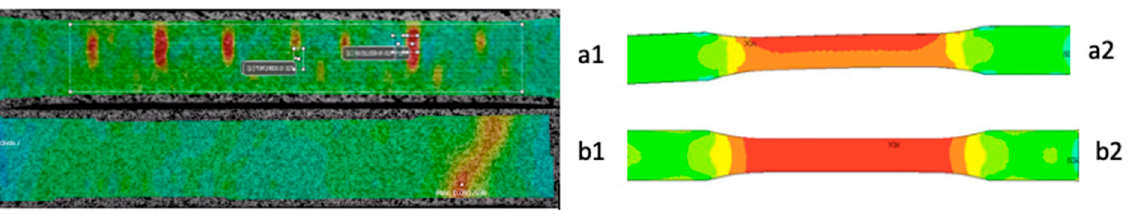
Figure 7. The simulation result for homogenous layer design ( b2 ) compared with DIC from experimental results ( b1 ). In contrast, DIC for experimental results of the inhomogeneous layer design ( a1 ) is compared with simulation results ( a2 ).